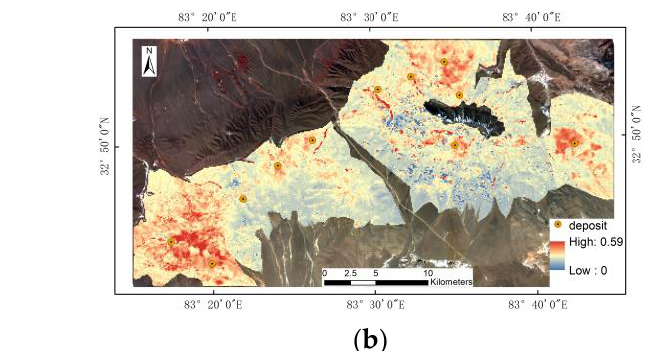
Figure 8. Position and depth of the feature absorption peak in the 2185 – 2215 nm spectral range based on GF-5 data: ( a ) Wave2200 and ( b ) Deep2200.